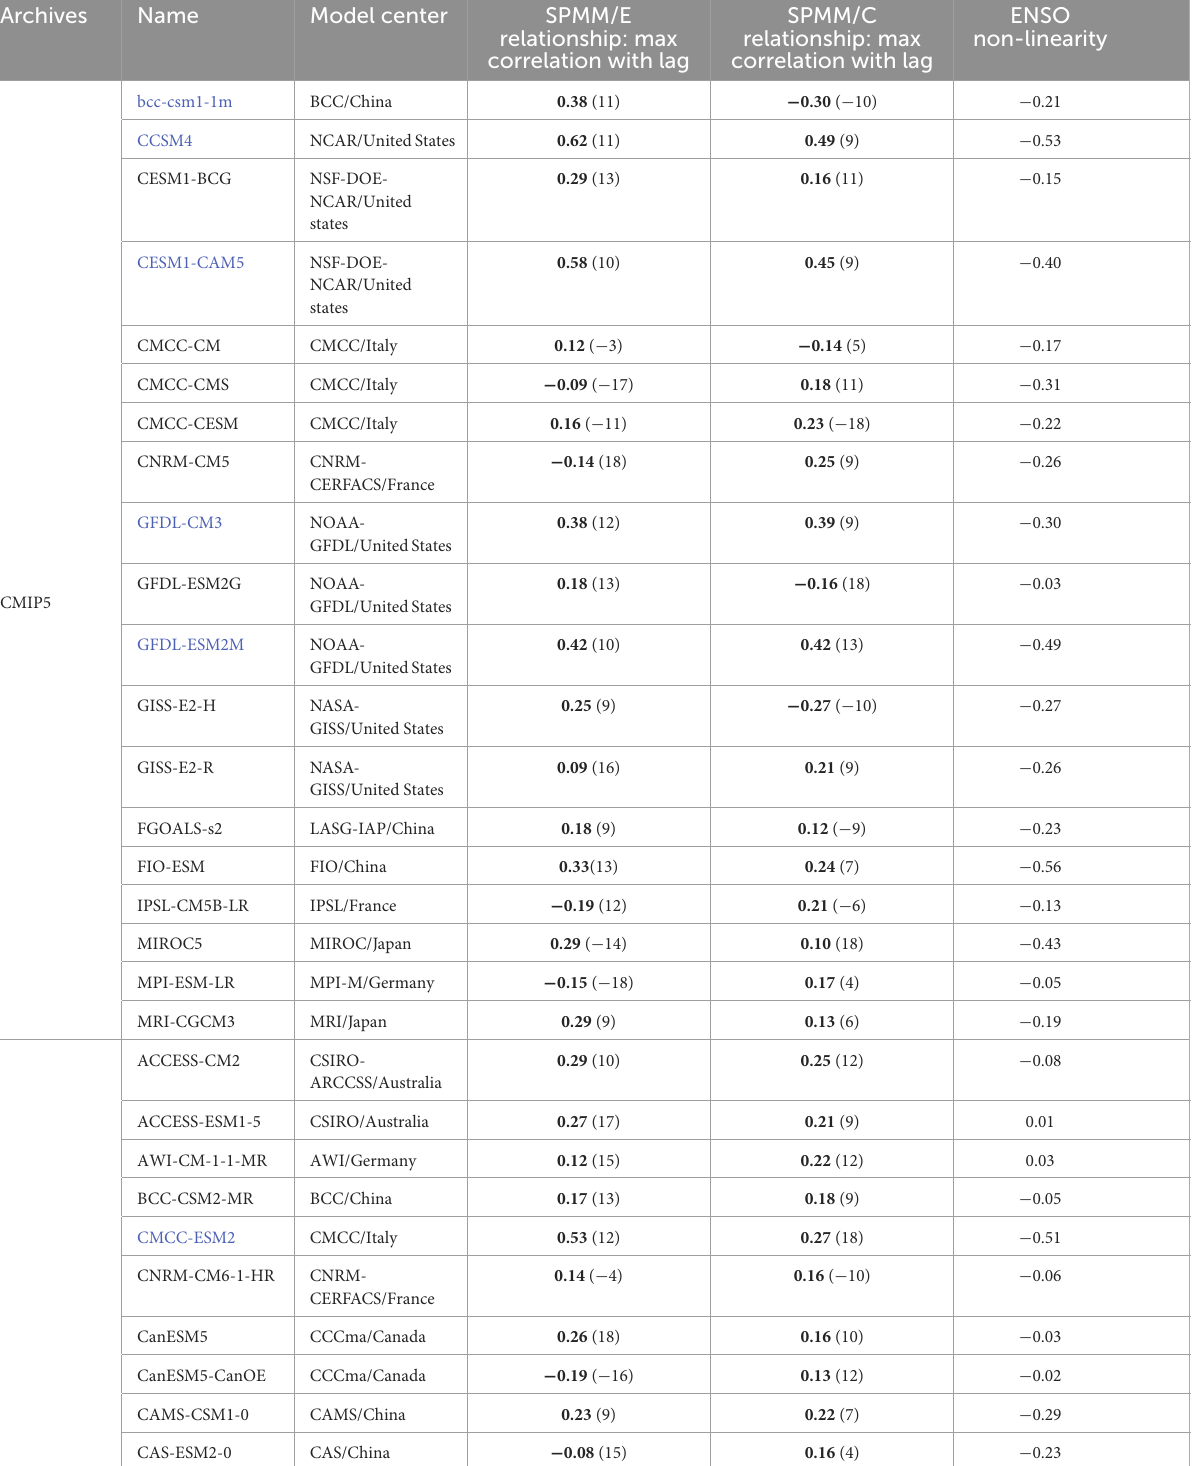
TABLE 1 Description of the selected 62 models and statistics: The SPMM/E relationship is diagnosed from the maximum value of the correlation between the SPMM and E indices.